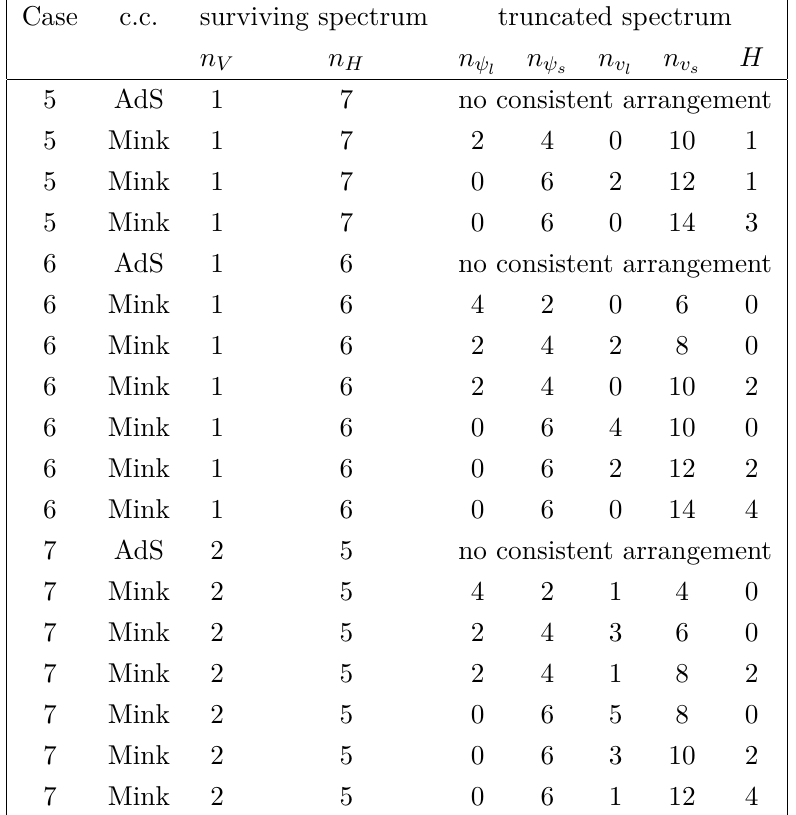
Table 5 . Supersymmetry breaking patterns and truncation of the spectrum — cases